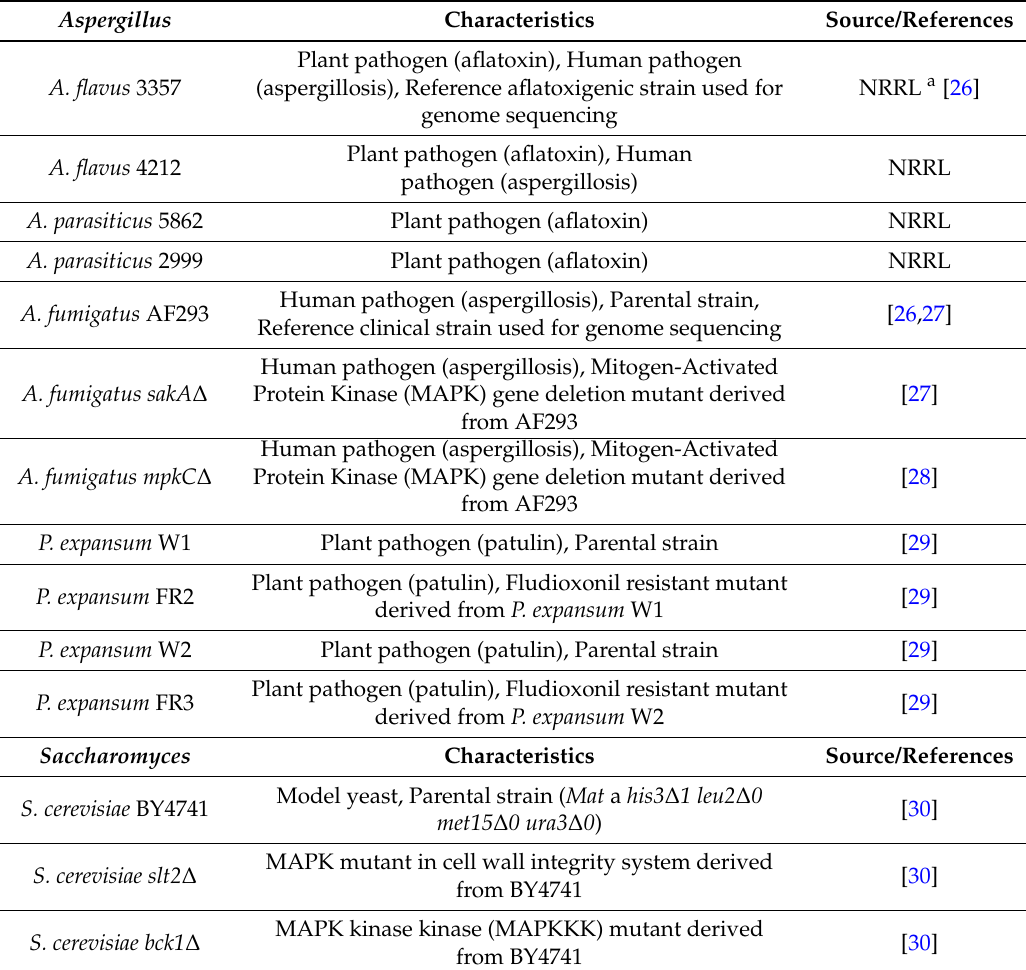
Table 2. Microbial strains used in this